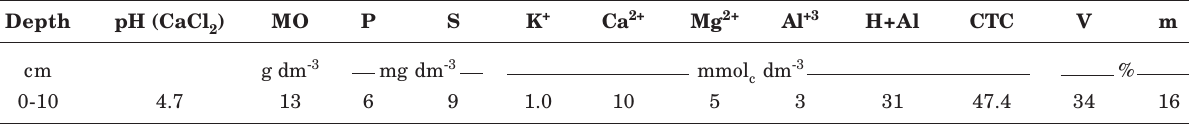
Table 1. Soil chemical properties prior to the